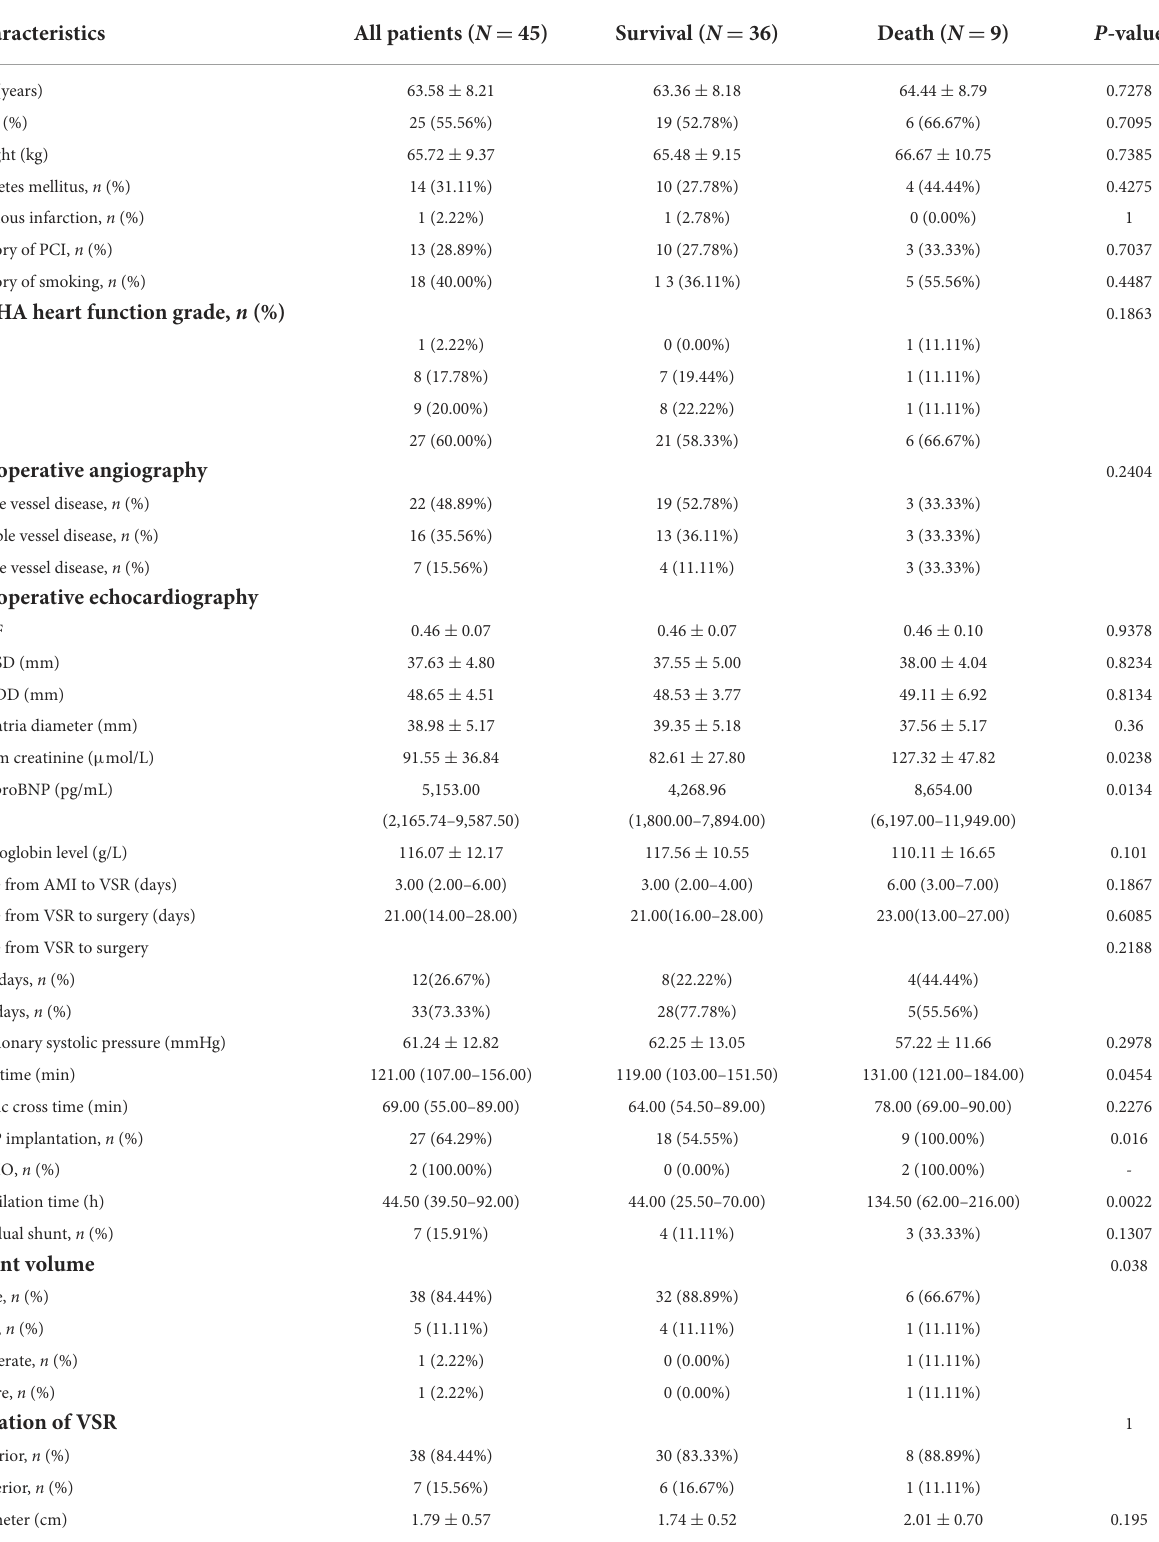
TABLE 1 Patient